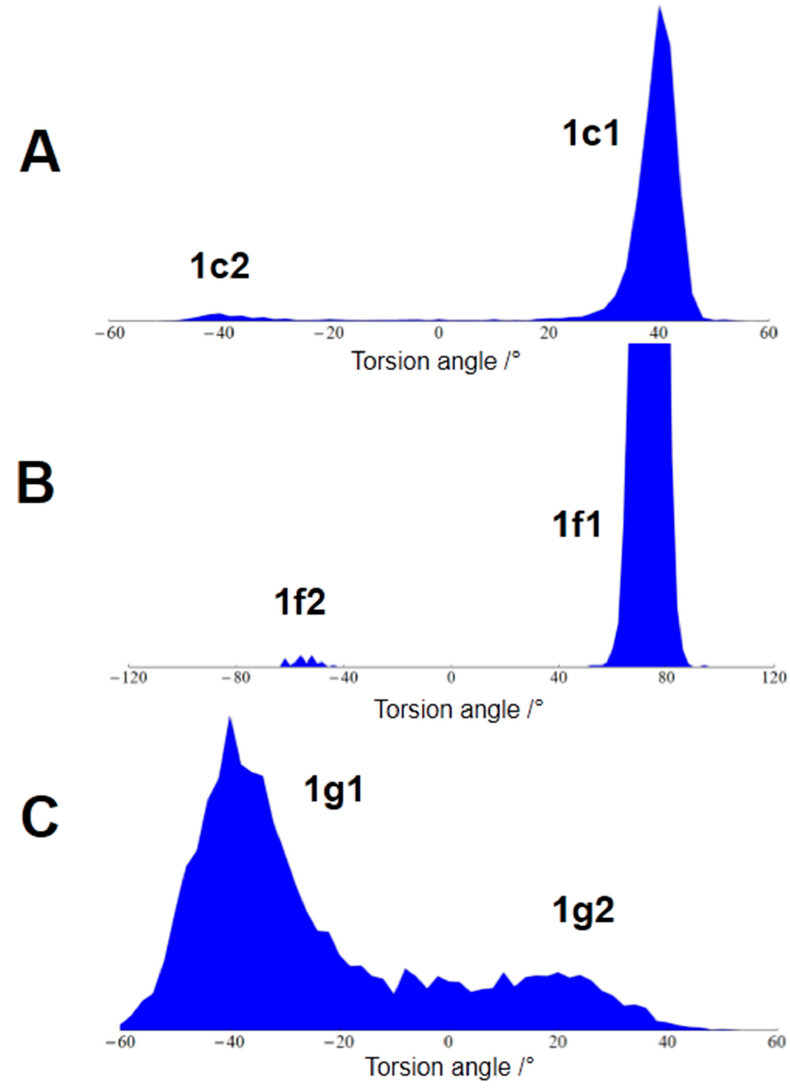
Figure 3. Torsion angle probability distributions for the ring conformations derived from the trajec- tories in Figure 2. The total probability for the distributions adds up to 100%. ( A ) Torsion angle distribution for the C ring. The probability of minor conformation 1c2 amounts to 4.7%. ( B ) Torsion angle distribution for the F ring ( 1f2 : 0.4%). The 1f1 maximum is cut off to show the minor 1f2 contribution. ( C ) Torsion angle distribution for the G ring ( 1g2 : 19.6%).